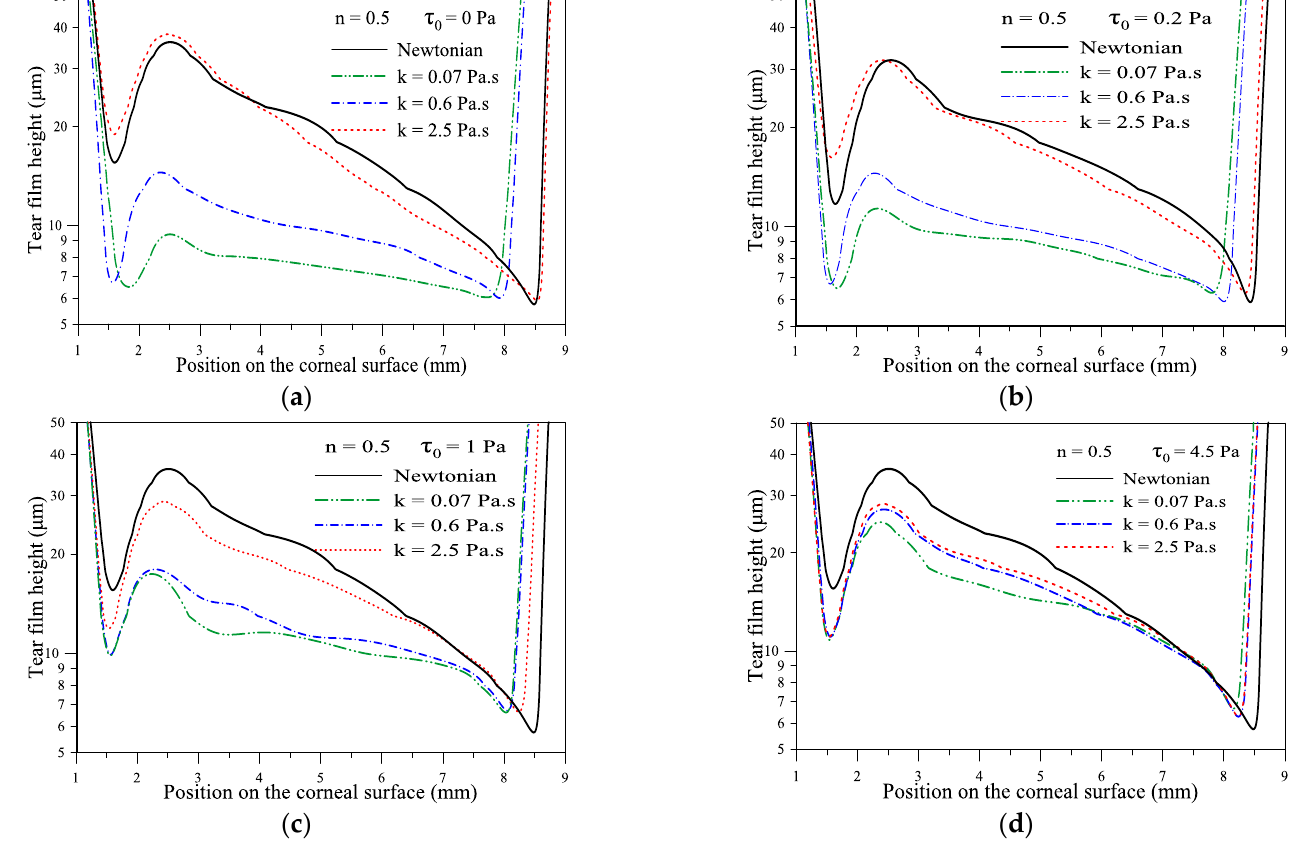
Figure 4. ( a – d ) the effect of consistency k, n= 0.5, τ 0 = 0, 0.2, 1 and 4.5 Pa at t = 0.18 s.